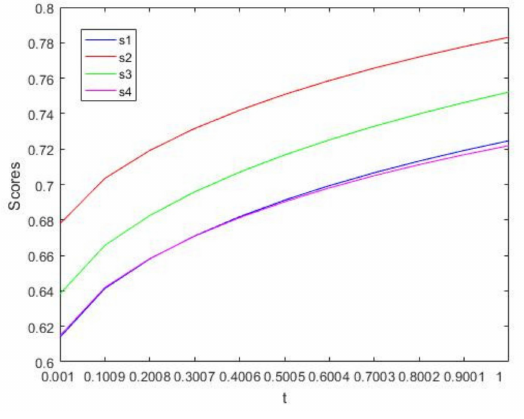
Figure 7. s = 1, t ∈ [ 0.001, 1 ] .